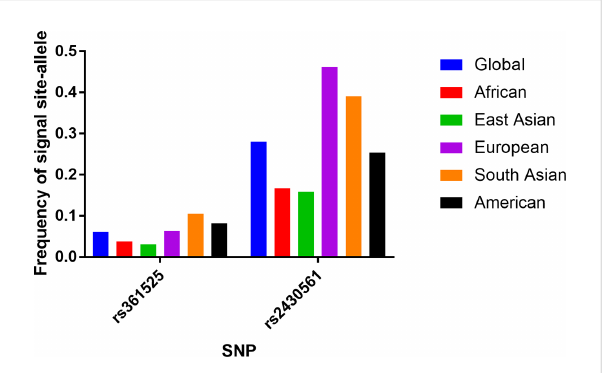
FIGURE 2 Minor (mutant) allele frequencies for rs361525 and rs2430561 polymorphisms based on data from the online 1000 Genomes database.